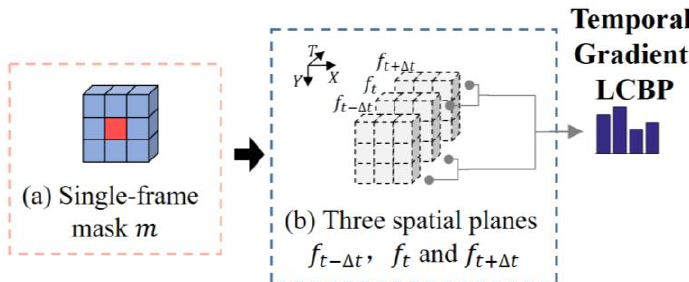
Figure 6. The encoding process of Temporal Gradient LCBP. ( a ) The diagram of single-frame mask. ( b ) The sampling range of the spatial planes 𝑓 𝒕−∆𝒕 , 𝑓 𝑡 and 𝑓 𝑡+∆𝑡 .